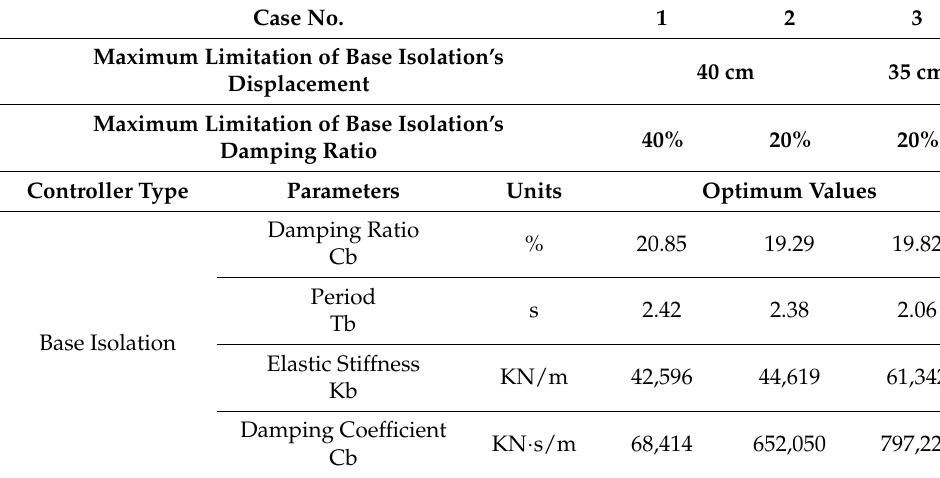
Table 5. Properties of optimized base-isolated subsystem.